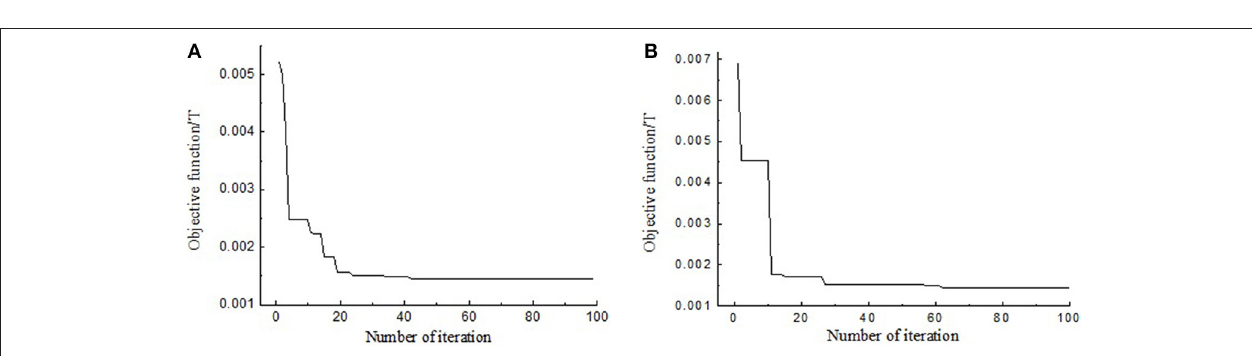
Value of objective function using PSO